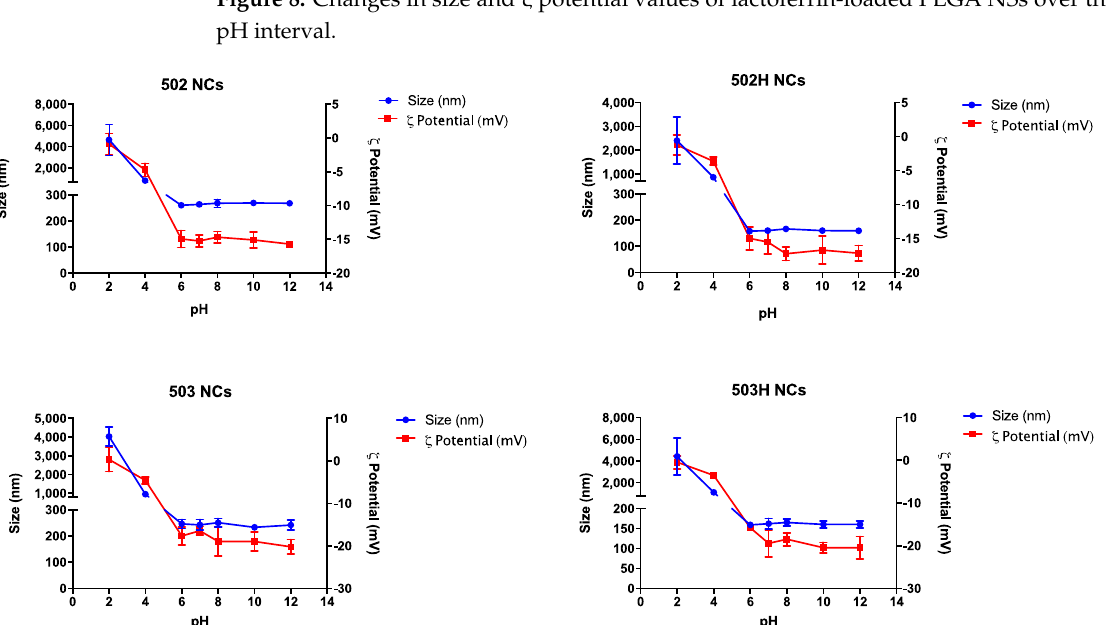
Figure 9. Changes in size and ζ potential values of lactoferrin-loaded PLGA NCs over the studied pH interval.